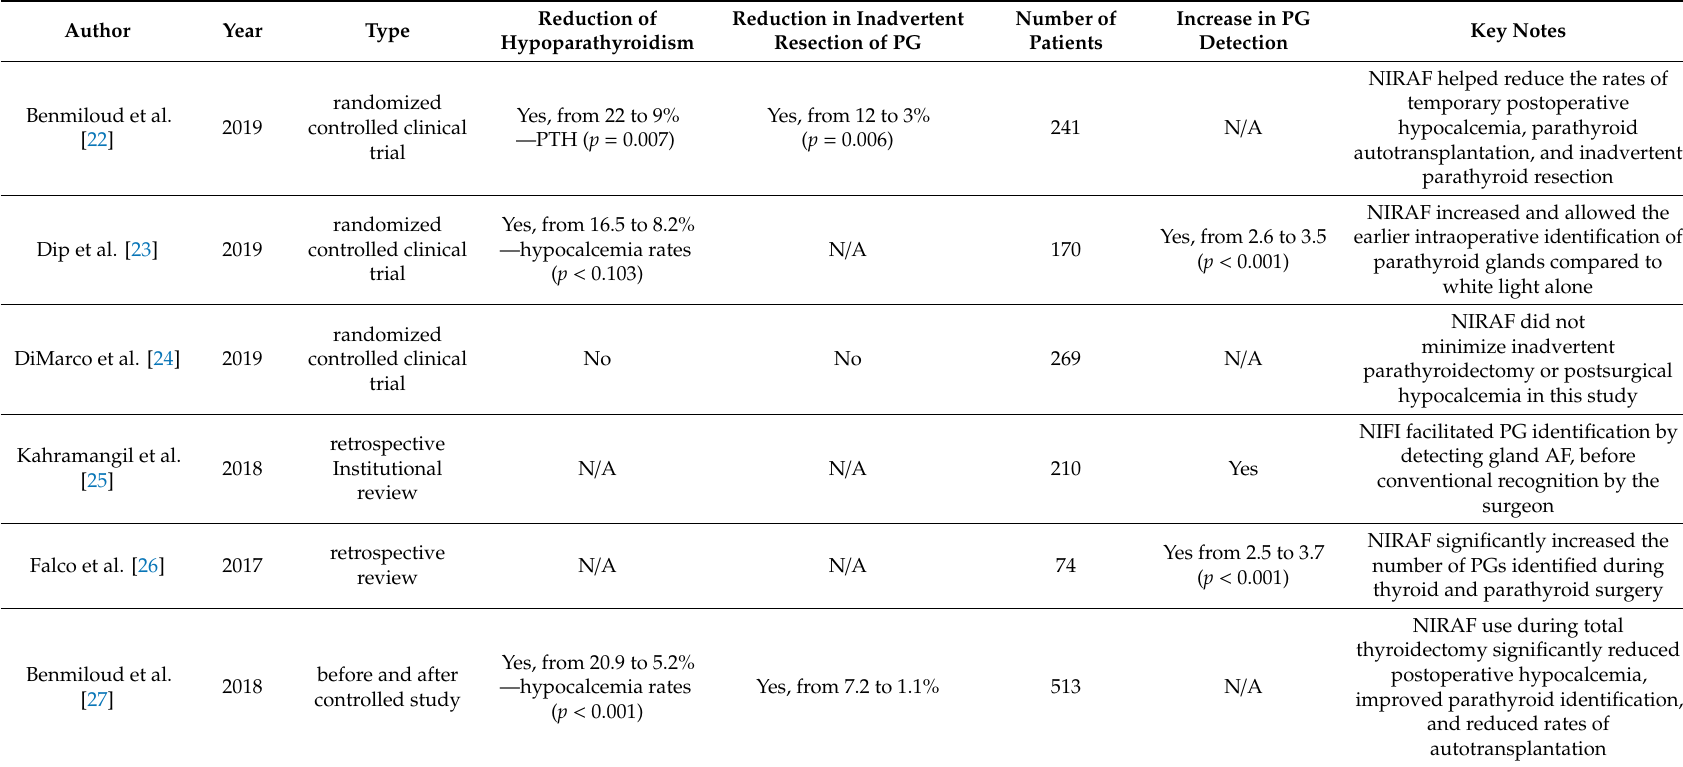
Table 1. Recent studies that evaluate the benefits of near-infrared (NIR) imaging in thyroid